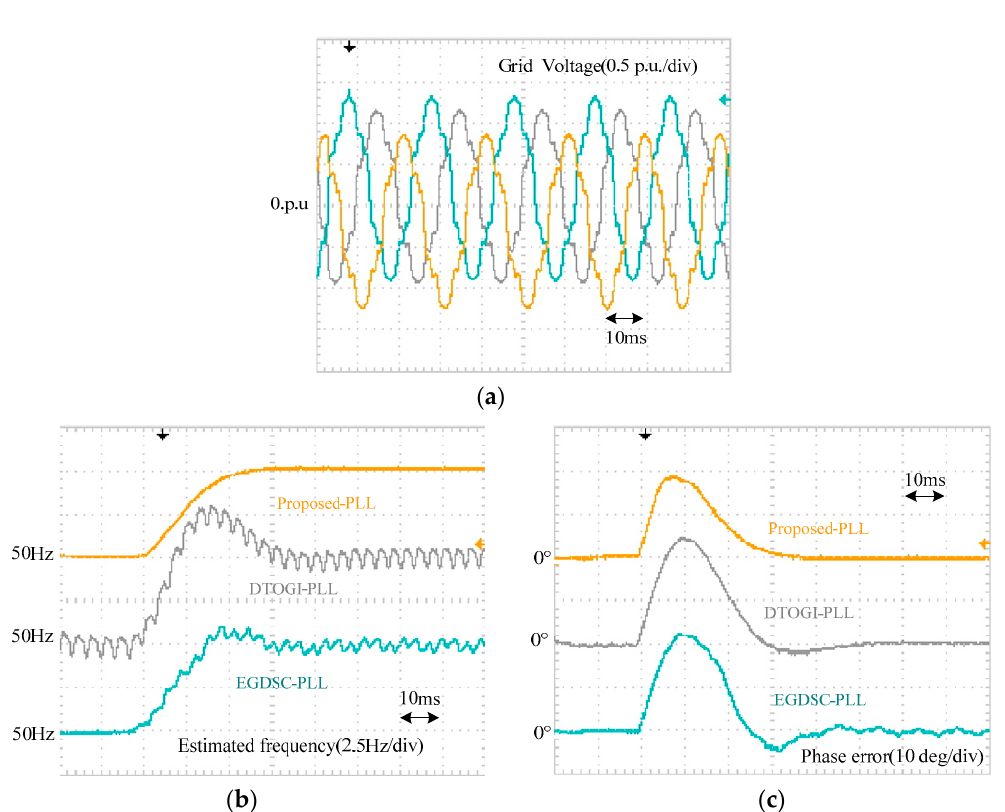
Figure 19. Experimental waveforms when the grid voltages are distorted with a frequency step change of +5 Hz. ( a ) is the grid voltage waveform, ( b ) is the estimated frequency waveform, and ( c ) is the phase error waveform .